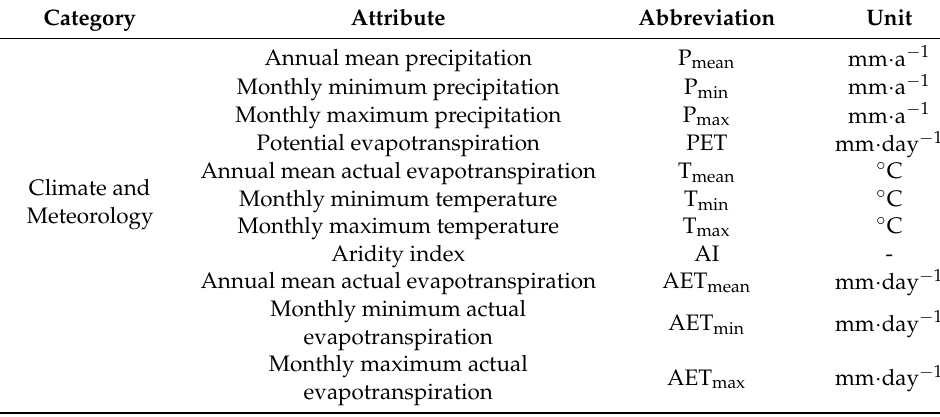
Table 1. List of variables as descriptors of river basin